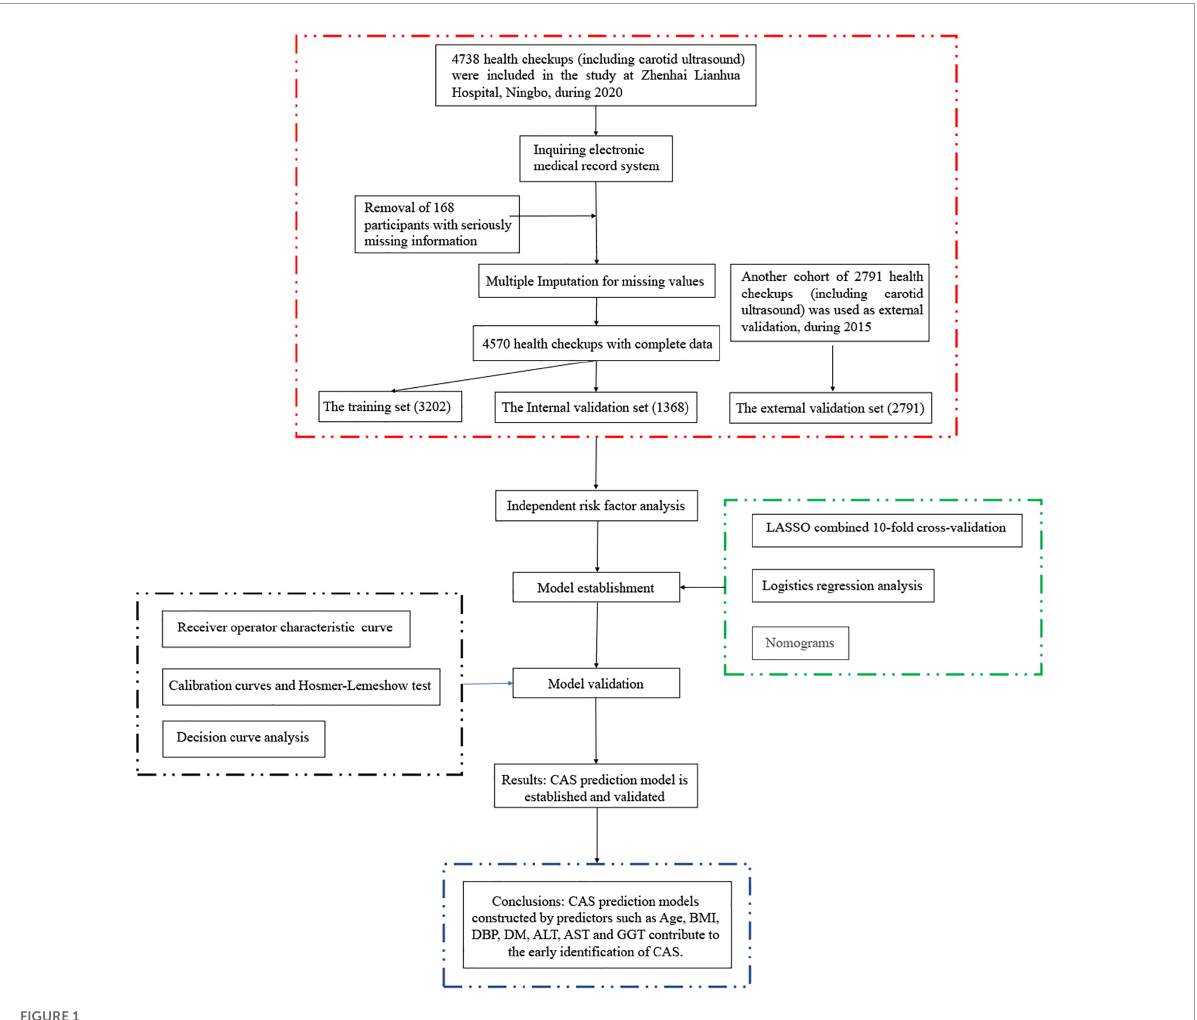
FIGURE1 Flowchart of the